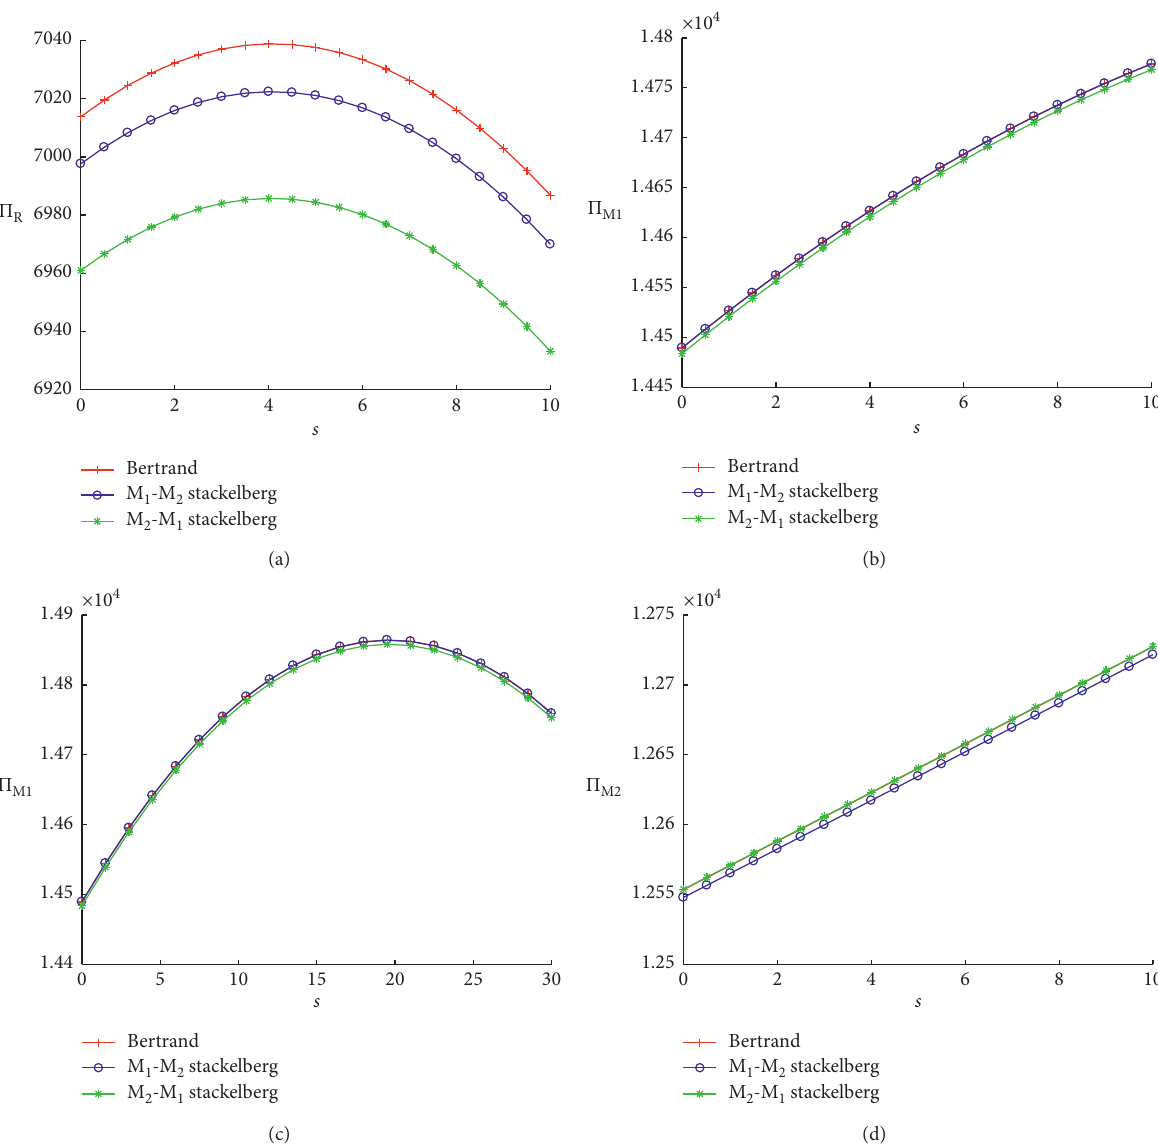
Figure 3: Influence of s on profit functions under different